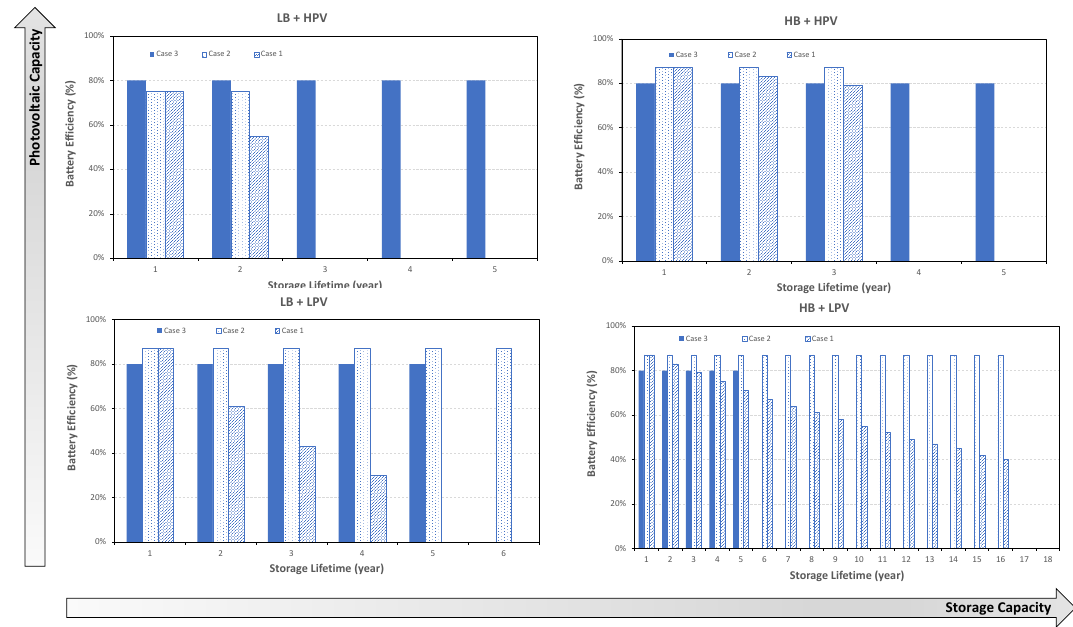
Figure 11. Battery efficiency evolution over its lifetime for all scenarios.